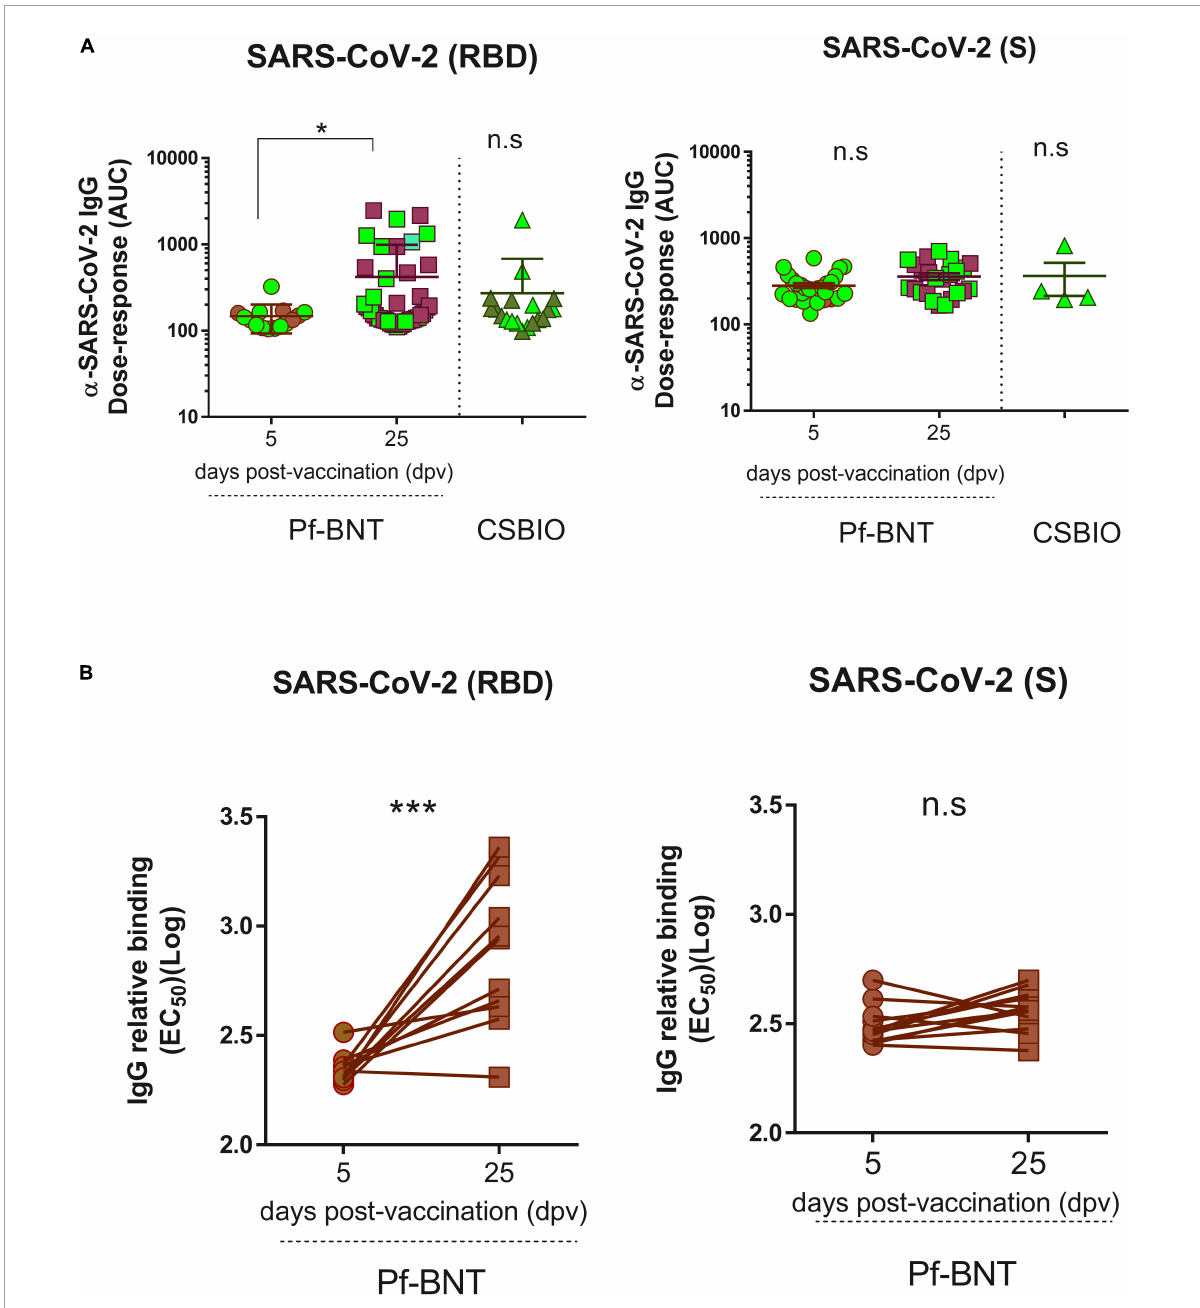
FIGURE4 Severe acute respiratory syndrome coronavirus 2 IgG Dose-response against the RBD and the S proteins. An area under curve (A) values were estimated from dose response curves with non-linear regression obtained from twofold serially diluted (eight dilutions) IgG positive serum samples against the RBD ( left panel ) and S ( right panel ) proteins of SARS-CoV-2 for both vaccine recipients, Pf-BNT and CSBIO at different dpv. Participants with record of COVID-19 (PCR-positive test) before vaccination are highlighted in light green. (B) Comparison between EC 50 values obtained from paired-serum samples collected after 5 and 25 dpv for Pf-BNT vaccinees against the SARS-CoV-2 RBD ( left panel ) and S ( right panel ) proteins. Mann–Whitney test: * p < 0.05, ** p < 0.01; paired t -test: *** p < 0.001. n.s., non-significant differences. Each group of data in the scatter plots represent either the area under the curve (AUC) (A) or the IgG-binding concentration 50 (EC 50 ) (B) based on the absorbance (OD) values obtained from individual serum sample per vaccine group against the three SARS-CoV-2 antigens, including the mean ± SEM (standard error) of individual